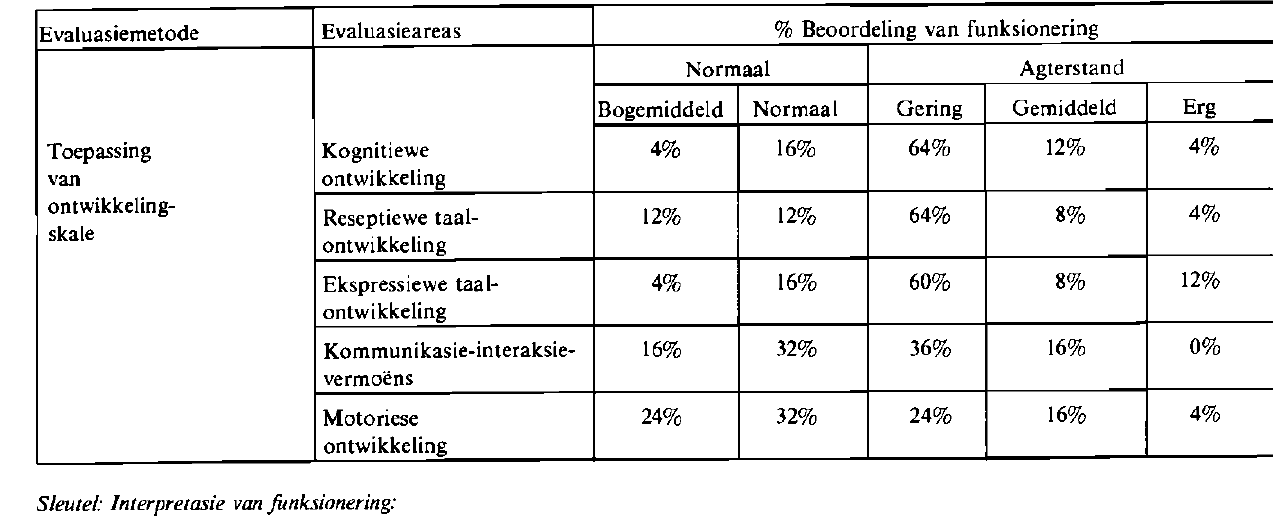
Tabel 7: Opsommende weergawe van die proefpersone (n = 25) se funksionering soos bepaal deur die verskeie ontwikkelingskale